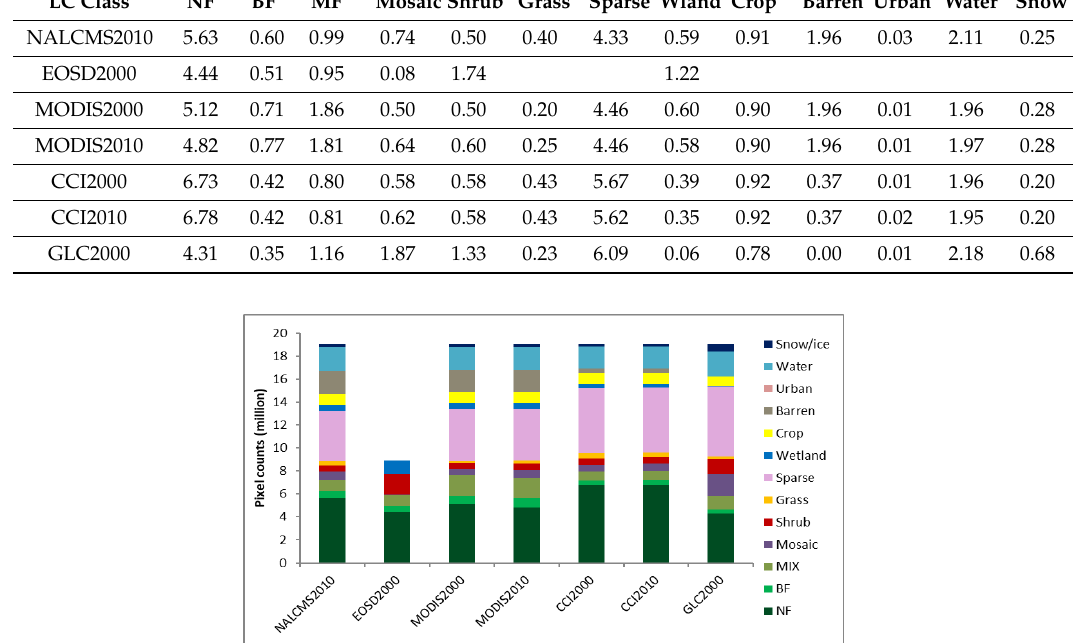
Figure 4. Pixel counts for each land cover class under the common legend across Canada. Please note that the EOSD dataset is only for forested areas. that the EOSD dataset is only for forested